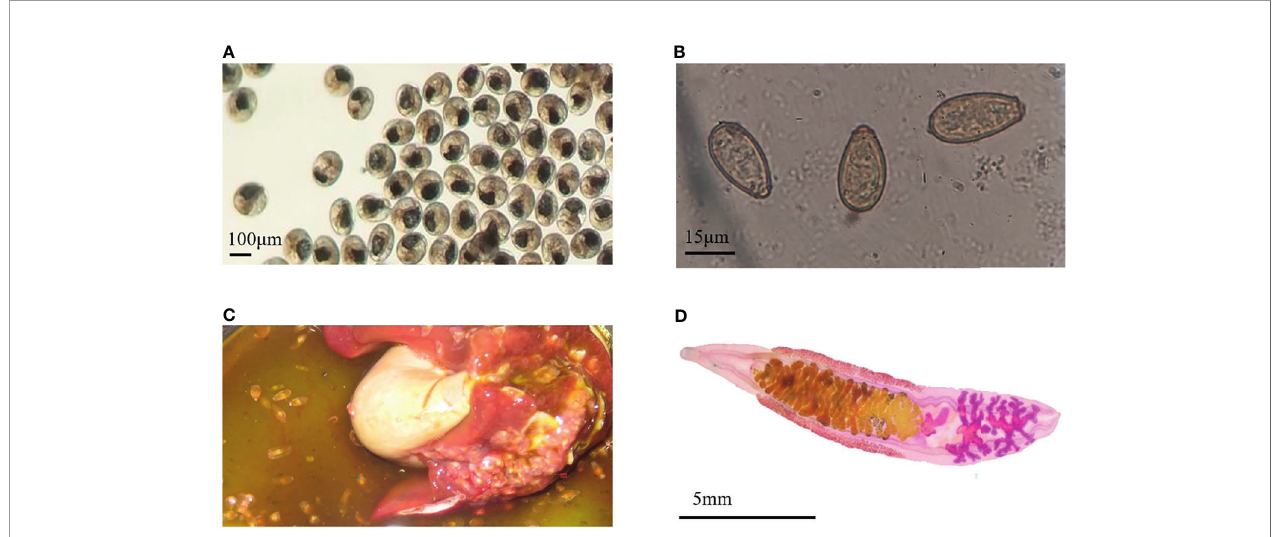
FIGURE 1 | Infection characteristics. (A) The Metacercariae of Clonorchis sinensis used to infect rabbits. (B) Clonorchis sinensis eggs observed under an optical microscope. (C) Adult worms in the hepatobiliary tract. (D) The adult worm collected from the liver of infected